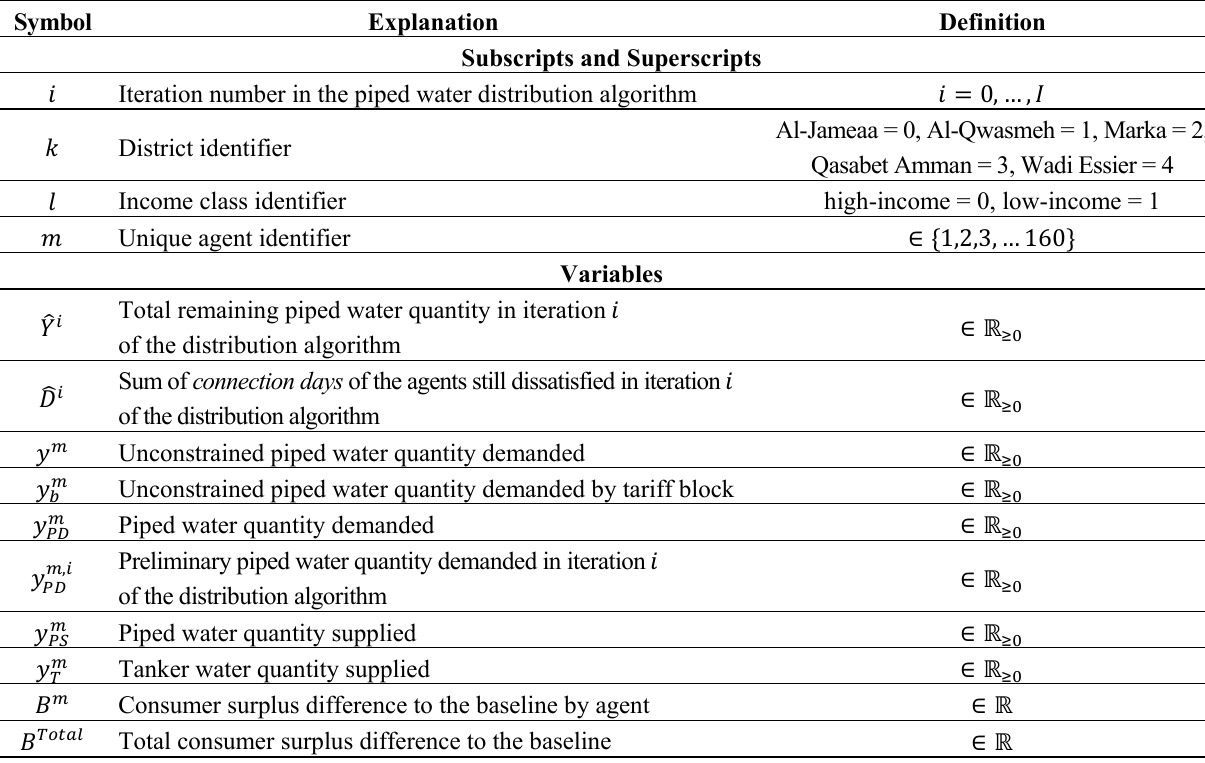
Table 1. Variables, subscripts, and